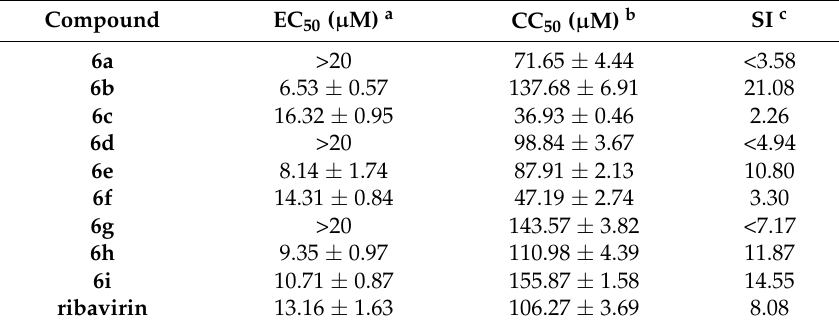
Table 2. Antiviral activities and cytotoxicities of isoflavone